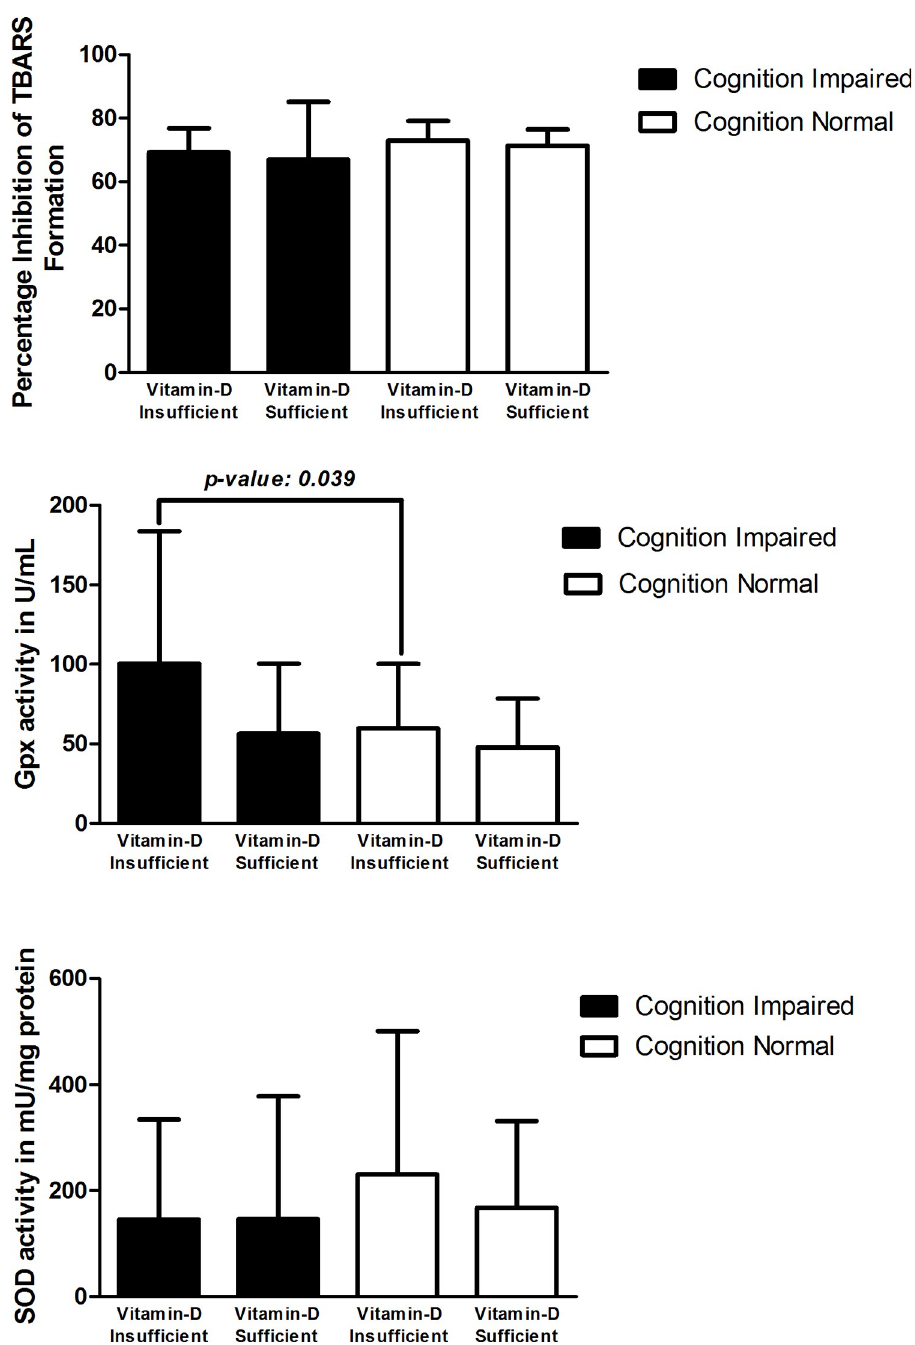
Fig 5. A. Comparison of total antioxidant activity by TBARS in non-diabetic subjects with vitamin-D and cognition status, B. Comparison of glutathione peroxidase (GPx) activity in non-diabetic subjects with vitamin-D and cognition status, C. Comparison of superoxide dismutase (SOD) activity in non-diabetic subjects with vitamin-D and cognition status.